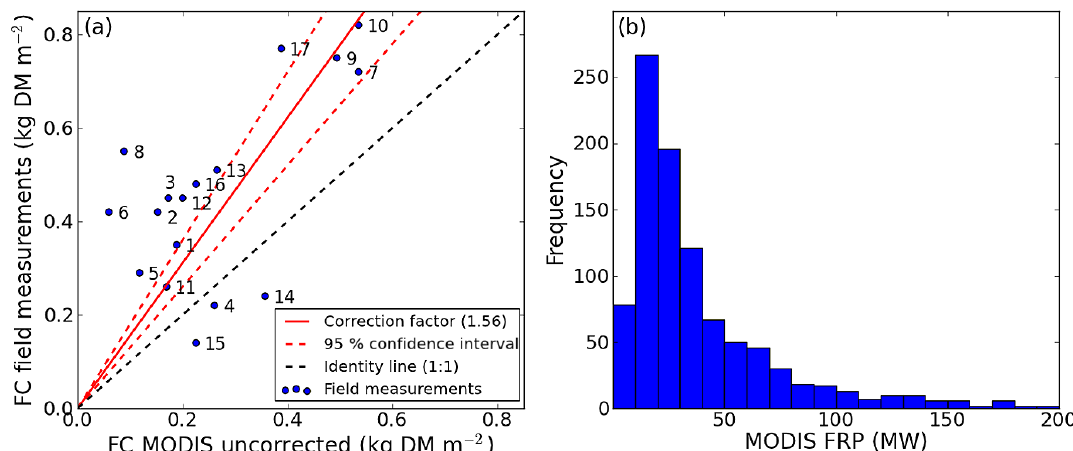
Figure 3. Relationship between MODIS FRP detections and fuel consumption (FC). (a) Comparison of MODIS-derived fuel consumption without correction for uncertainties in the FRE estimates with field measurements of fuel consumption. The slope between the uncorrected MODIS-derived FC and the FC from field measurements (red line; slope is 1.56) is used to correct the MODIS-derived FRE per unit area burned and estimate absolute fuel consumption. The red dashed lines indicate the bootstrapped 95% confidence interval of the slope (1.30– 1.80), here used as an estimate of uncertainty. The blue dots and numbers refer to the individual field studies (van Leeuwen et al., 2014; Table 1). (b) Distribution of MODIS FRP detections (binned in classes of 10MW wide) for a frequently burning 0.25 ◦ grid cell in northern